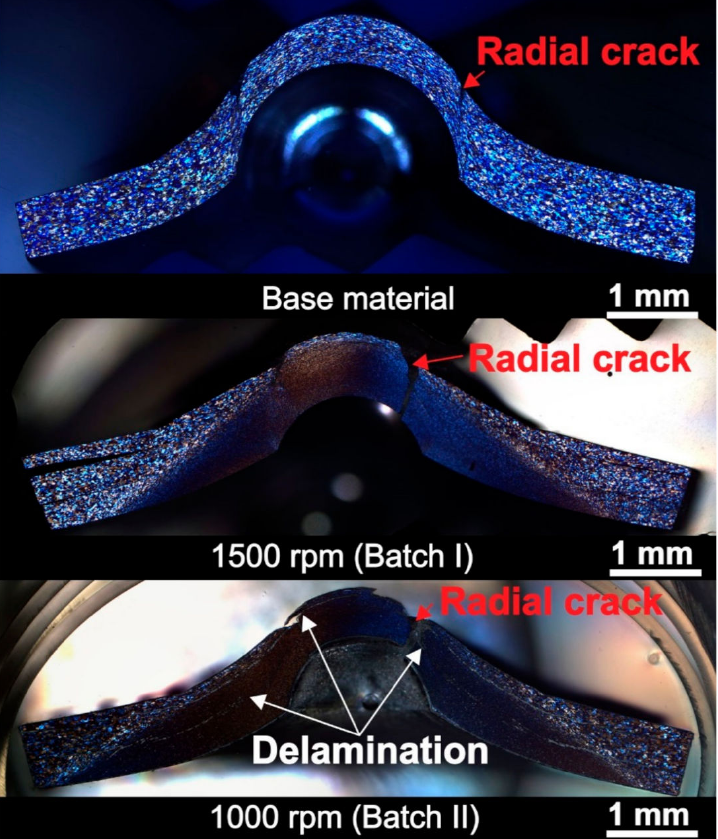
Figure 14. Macrographs of small punch test specimens of base material and samples welded with minimum rotational speeds from both batches (strain hardened samples).